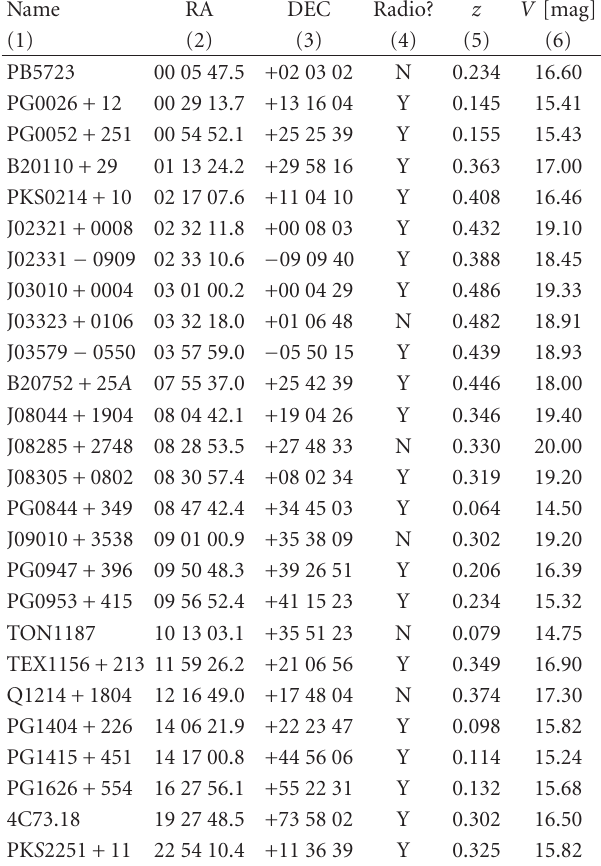
Table 1: The sample. (1) Target name. (2-3) Right ascension and declination (J2000). (4) Is the target detected in radio wavelengths, according to the [69] catalogue? (5) Catalogue redshift. (6) Appar- ent visual magnitude of the